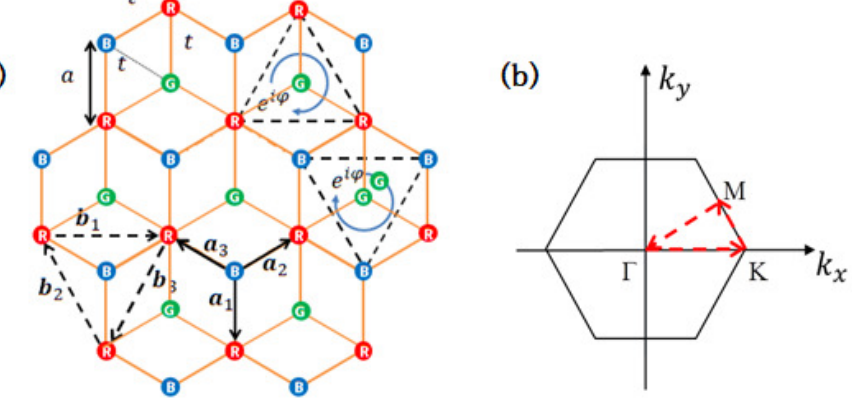
Figure 1. ( a ) Geometry of the dice lattice. R , B , and G are sublattice sites, and are marked with red, blue, and green dots respectively. The lattice constant a is taken as a = 1. The vectors a n ( n = 1,2,3) link the nearest-neighbor sites that pertain to different sublattices. The vectors b n ( n = 1,2,3) link the nearest-neighbor R sites or B sites. The circle arrows represent the next-nearest-neighbor tunnelings accompanied by a phase e i φ . ( b ) The first Brillouin zone of the model. Γ , K, and M are high-symmetry points in the high-symmetry path, and are connected by three red dashed